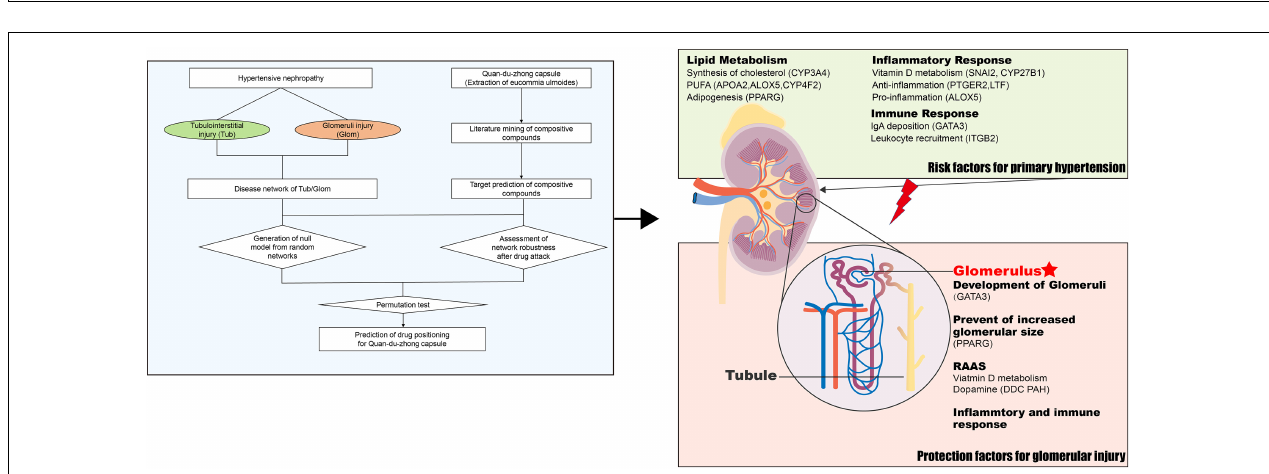
FIGURE 5 | Hierarchy network of chemical compound, drug-attacked nodes in the glomerular network and HN related pathological processes. Compounds with red edge represent drug with anti-hypertensive activity.